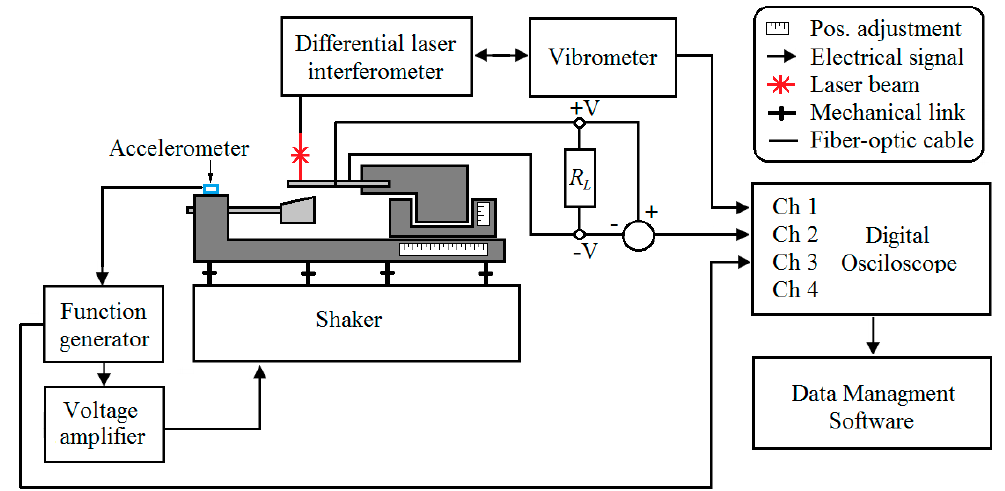
Figure 8. Schematic representation of experimental setup.